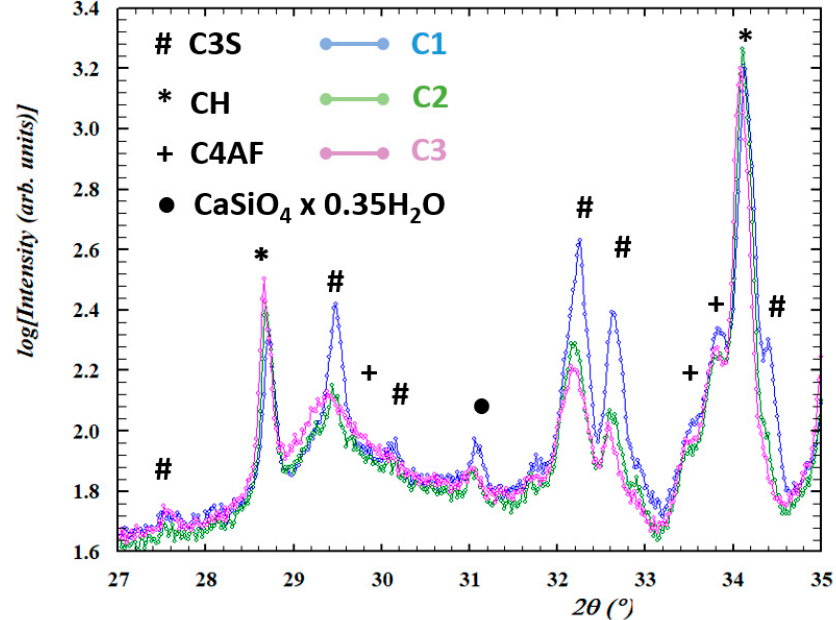
Figure 9. XRD diffraction patterns (normalized to corundum internal standard) for C1, C2 and C3 samples with indicated peaks from the most abundant crystalline phases present in the cement samples. C3S—tricalcium silicate (nonhydrated), CH—calcium hydroxide (main hydration product), C4AF—tetracalcium alumino ferrite. Table 2. Weight content of the most abundant crystalline phases present in cement samples with respect to corundum as an internal standard.